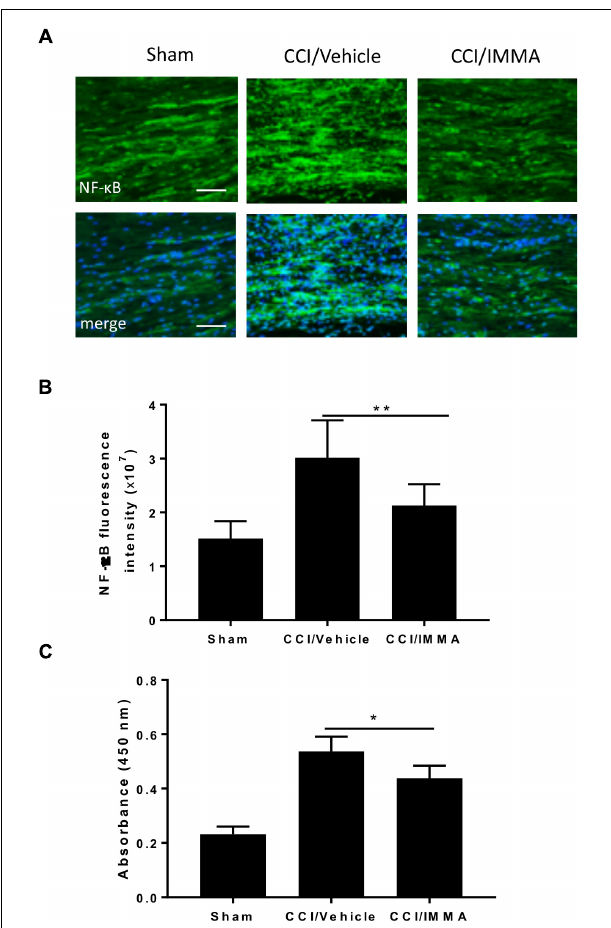
FIGURE 5 | Treatment with IMMA attenuated the phosphorylation of NF- κ B in ipsilateral sciatic nerve and the NF- κ B DNA binding activity in dorsal spinal cord of CCI mice. Activation of NF- κ B was detected by immunofluorescence staining with an antibody against phosphorylated NF- κ B in the ipsilateral sciatic nerve of CCI mice 7 days after surgery. Positive phosphorylated NF-kB staining in sciatic nerve was significantly greater in the CCI/vehicle group than that in the sham group and dramatically reduced by IMMA treatment (A) . The fluorescence intensity of NF-kB positive staining cells showed a twofold increase in the CCI/vehicle and significantly reduced by IMMA (B) . NF- κ B DNA binding activity was evaluated by ELISA using fresh spinal cord from mice 7 days after surgery. CCI/vehicle group showed an enhanced DNA binding activity compared to the sham, which was reduced by IMMA treatment (C) . ∗ p < 0.05 and ∗∗ p < 0.01 ( n = 10/group). One-way ANOVA was used for quantifying the differences in NF-kB fluorescence intensity (B) and absorbance at 450 nm (C) among the sham, vehicle and IMMA treated groups. The Tukey-Kramer post hoc test was used for all the comparison. The merged images in (A) showed the co-localization of DAPI (blue) with NF-kB (green). Scale bar = 250 µ m.